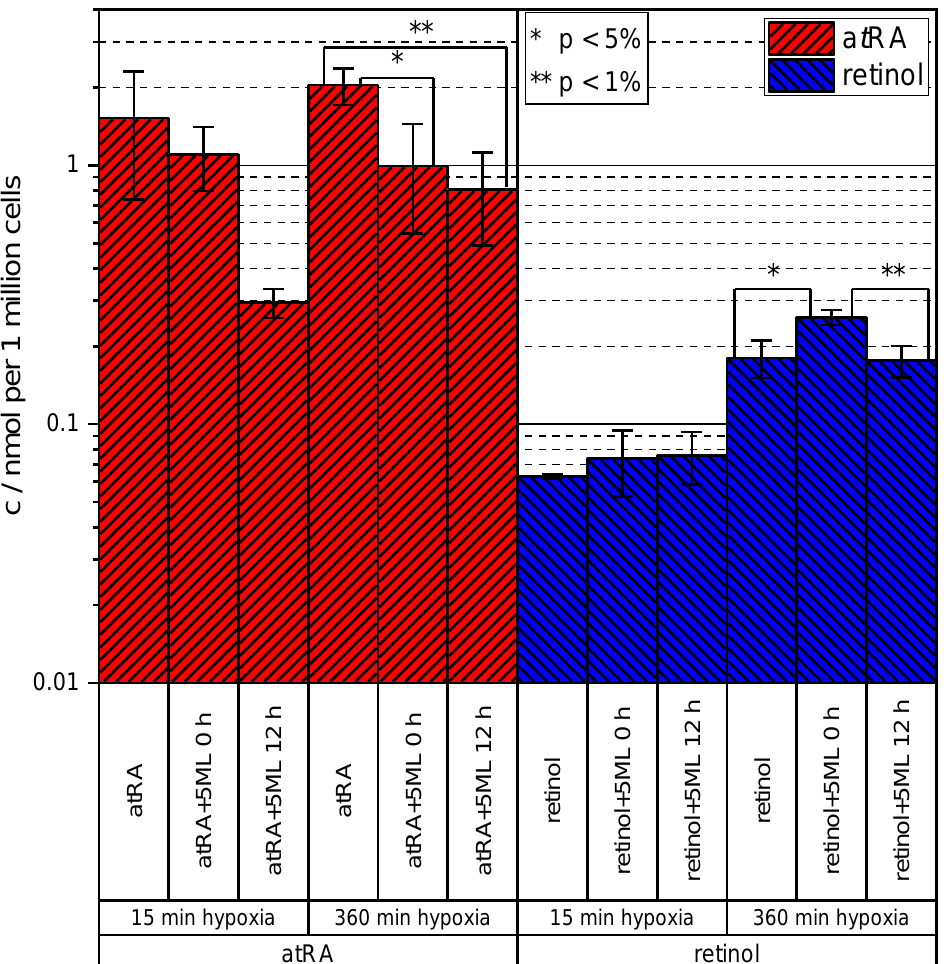
Figure 6. Results of the in vitro experiment measuring the inhibitory effect of 5ML on the a t RA uptake of HUVECs under hypoxic conditions. Hypoxic conditions were maintained for 15 min and for 360 min. Here, 5ML was added 12 h before the start of hypoxia or concurrently (0 h). The error bars represent the standard deviations of biological triplicates.